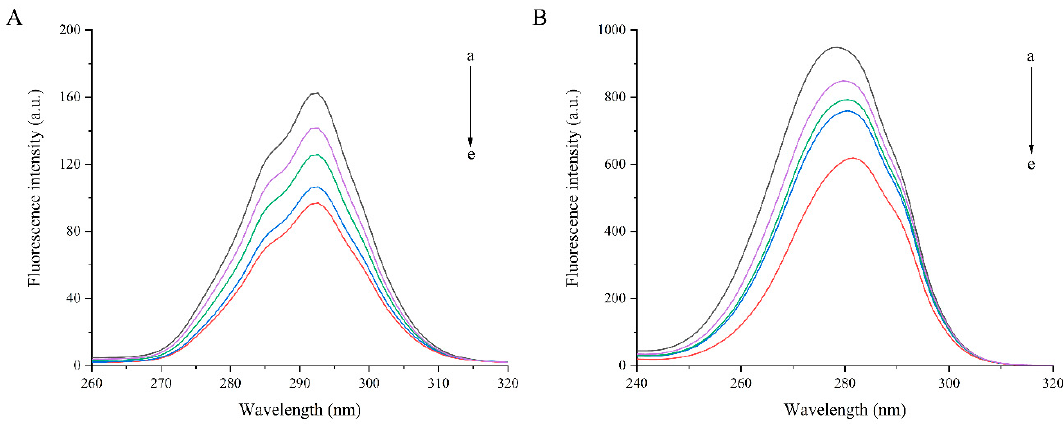
Figure 6. Synchronous fluorescence spectra of PGWP-SIF systems, a–e, PGWP, PGWP-SIF-A, PGWP-SIF-B, PGWP-SIF-C, PGWP-SIF-D. ( A : Δλ = 15 nm, B : Δλ = 60 nm).